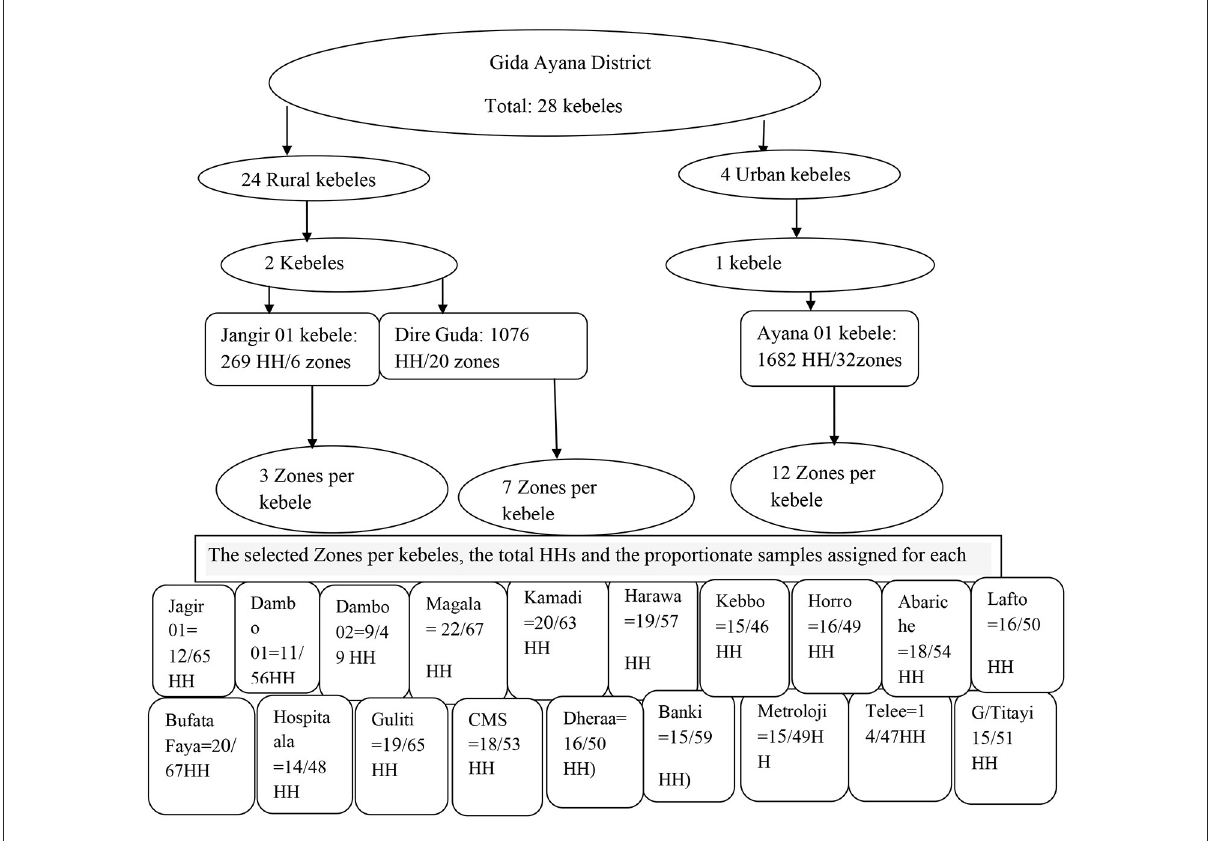
FIGURE1 Sampling technique to select study households in Gida Ayana district,